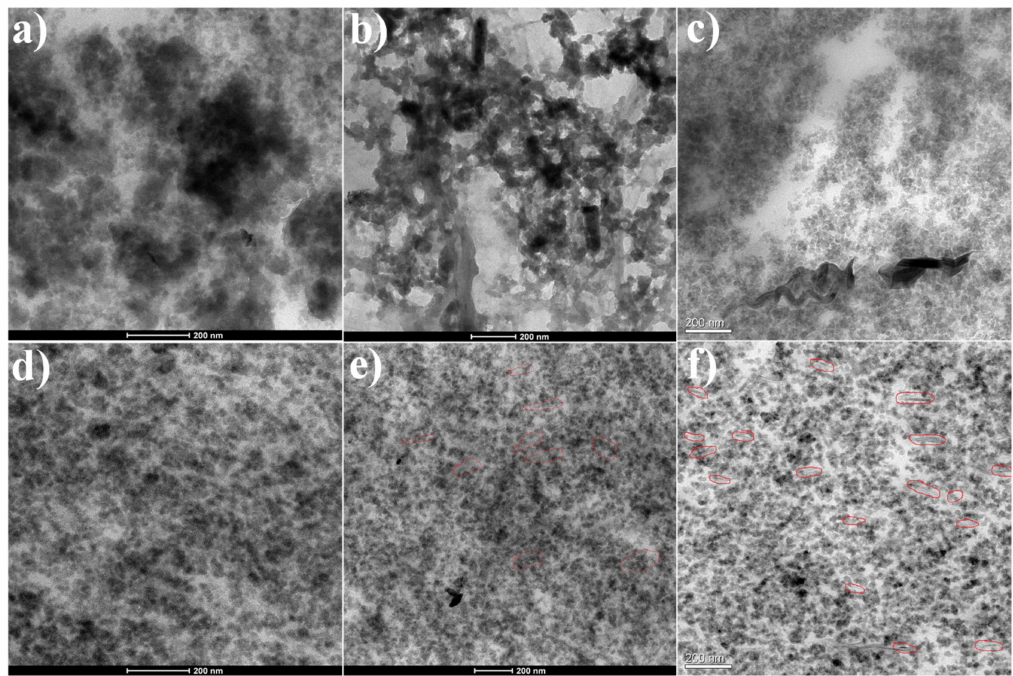
Figure 6. TEM images of the 60SiO 2 / NR composites prepared by ( a ) the rubber masterbatch and twin-roll mixing with silica (LMTM) method and ( d ) WCL method; TEM images of the 60SiO 2 / 1rGO / NR composites prepared by ( b ) the LMTM method and ( e ) WCL method; TEM images of the 60SiO 2 / 2rGO / NR composites prepared by ( c ) the LMTM method and ( f ) WCL